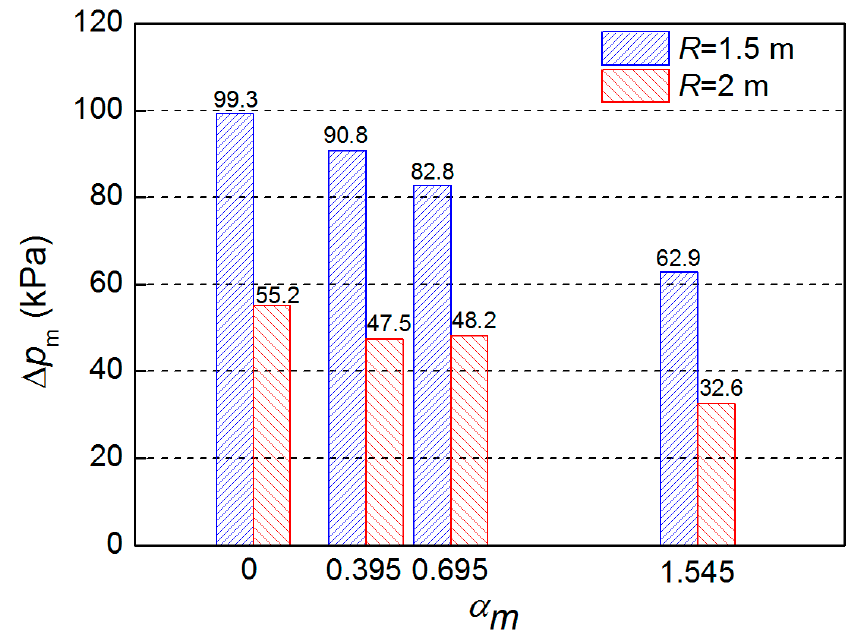
Figure 9. Peak overpressure under different α m values.